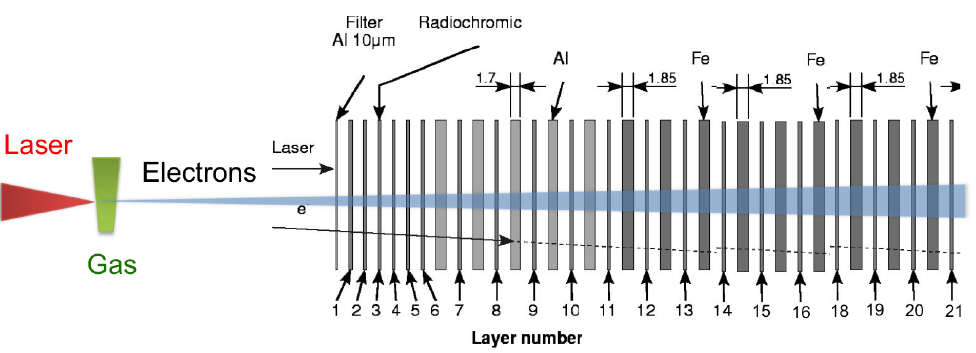
Figure 14. Layout of the SHEEBA detector set-up showing electron propagation direction, films type and distribution. The thickness of the metal layers is in